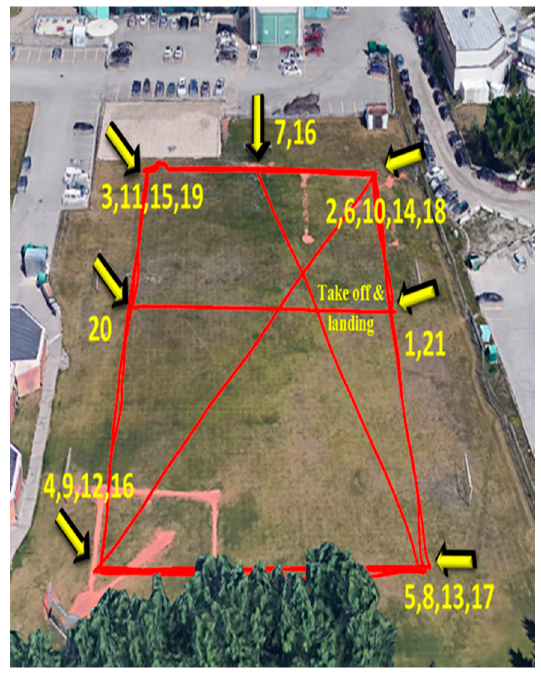
Figure 10. The trajectory of the quadcopter for the experimental flight.